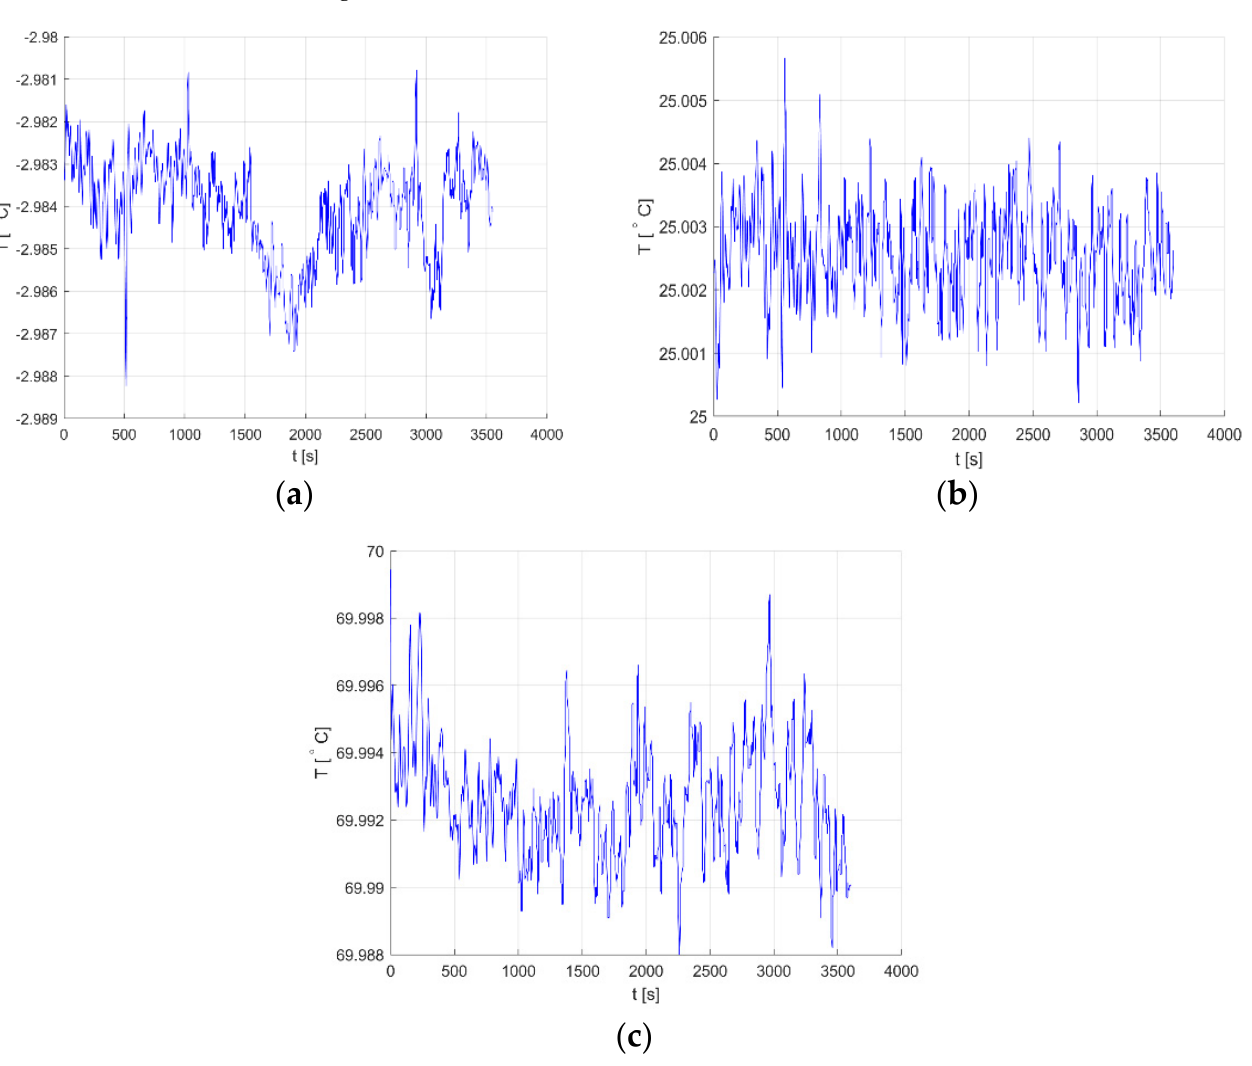
Figure 13. One-hour temperature stability of proposed system for three setpoints ( a ) − 3 °C; ( b ) 25 °C; ( c ) 70 °C.